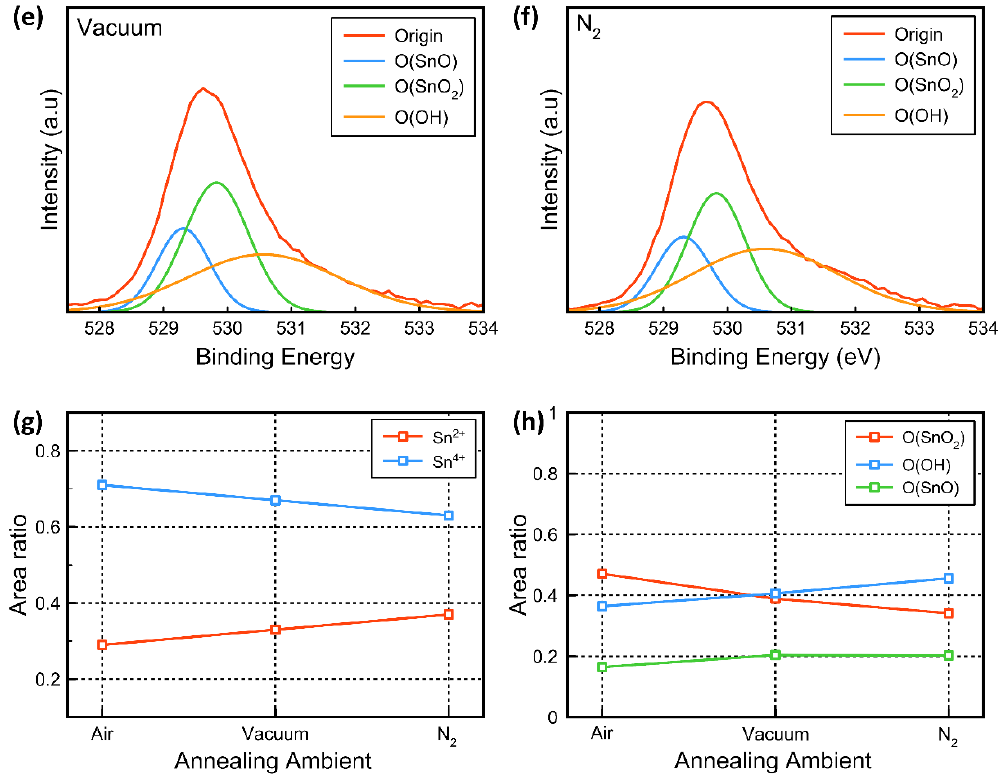
Figure 2. ( a )–( c ) Sn 3d 5/2 XPS spectra and ( d )–( f ) O1s XPS spectra of SnO 2 films annealed in air, vacuum, and N 2 . Sn 3d 5/2 ( g ) and O 1s ( h ) compositions of films annealed in different annealing ambient conditions.